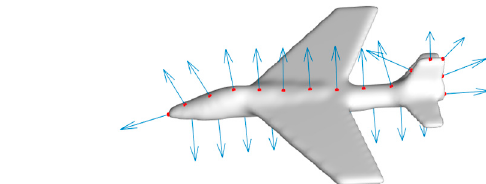
Figure 5. ( a ) Examples of blind contour following paths for model of Plane. ( b ) Examples of guided contour following paths by visually interesting points for model of Plane.